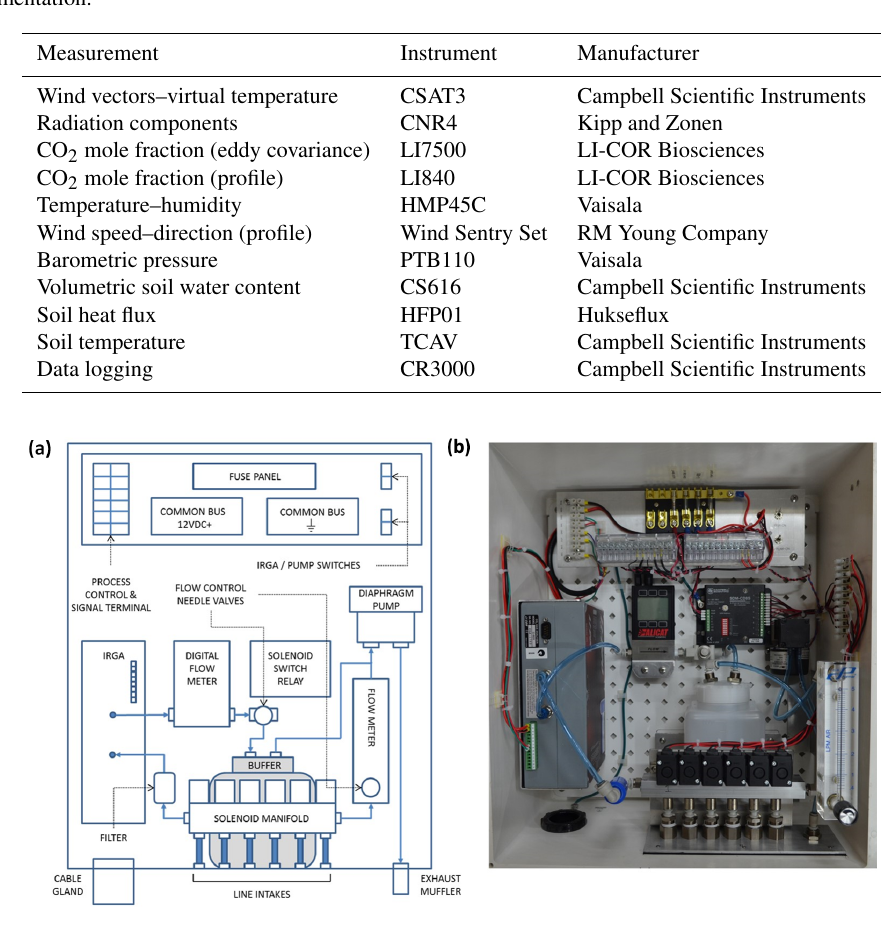
Figure 2. (a) Schematic and (b) photographic layout of profile gas analysis